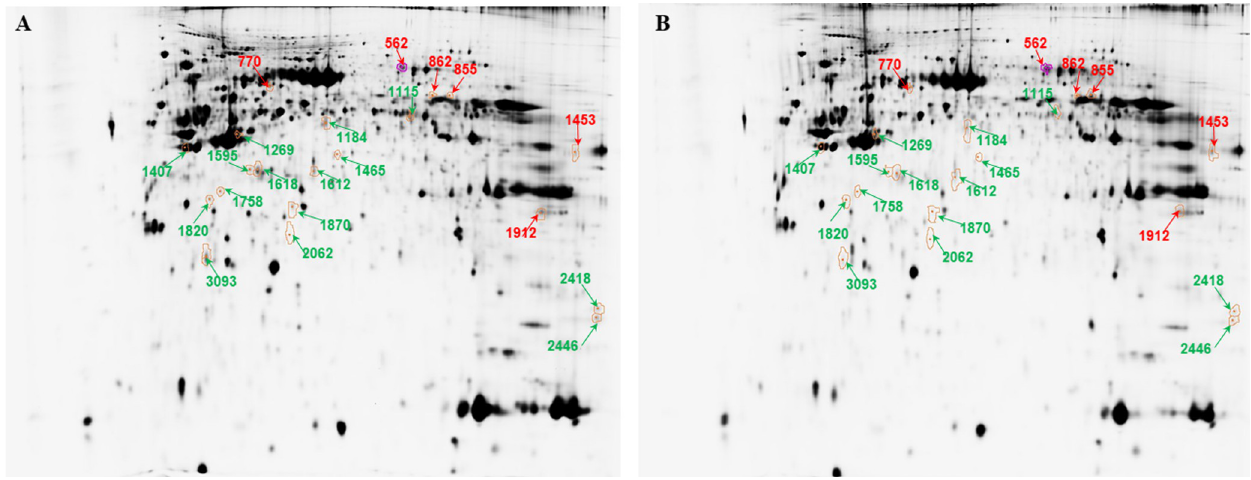
Fig 2. Representative 2D-DIGE profiling of differentially expressed proteins in the margin and center of SCC tumor. (A) single-channel image of proteins from tumor margin, (B) single-channel image of proteins from tumor center. Red numbers indicate proteins that are more abundant in center and green numbers indicate proteins with more abundance in margin. Twenty-one spots for SCC (numbers correlate with descriptions in S2 Table) with significantly different abundance between the margin and center of tumor are shown (p < 0.05).